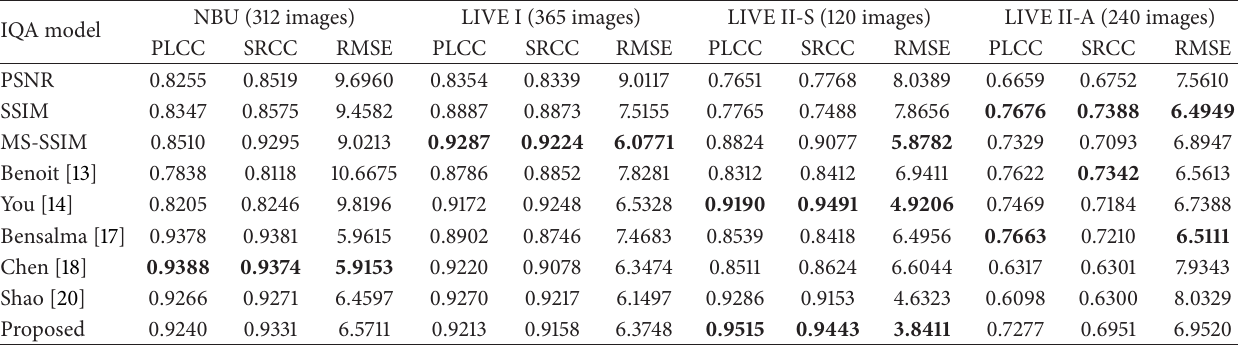
Table 1: Performance of the proposed method and the other seven schemes in terms of PLCC, SRCC, and RMSE on the four databases (the cases in bold: the best